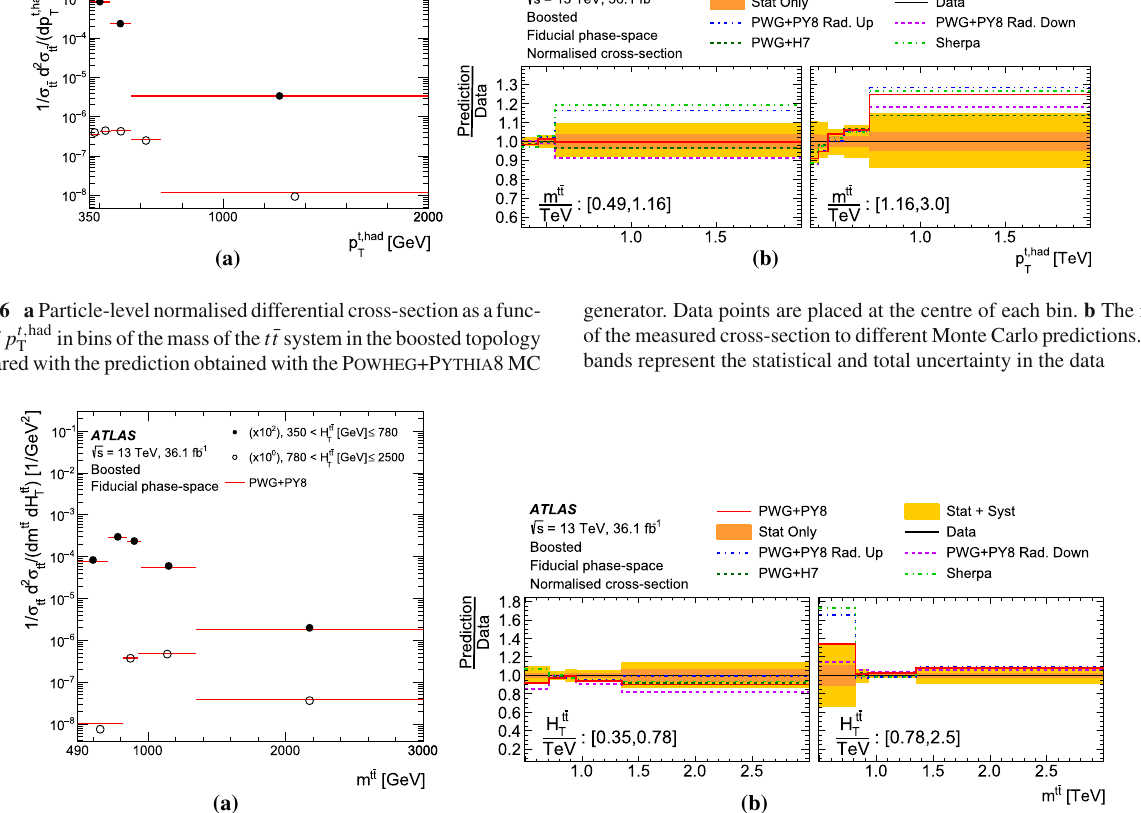
Fig. 47 a Particle-levelnormaliseddifferentialcross-sectionasafunc- generator. Data points are placed at the centre of each bin. b The ratio tion of the mass of the t ¯ t system in bins of H t ¯ t in the boosted topology of the measured cross-section to different Monte Carlo predictions. The T compared with the prediction obtained with the Powheg + Pythia8 MC bands represent the statistical and total uncertainty in the